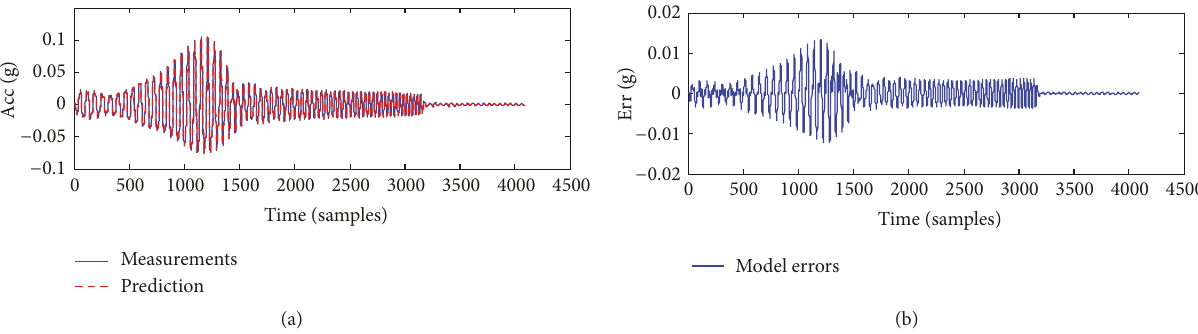
Figure 8: Prediction of actual response of the top floor of the structure for the (a) ARMANN models and (b) model errors.